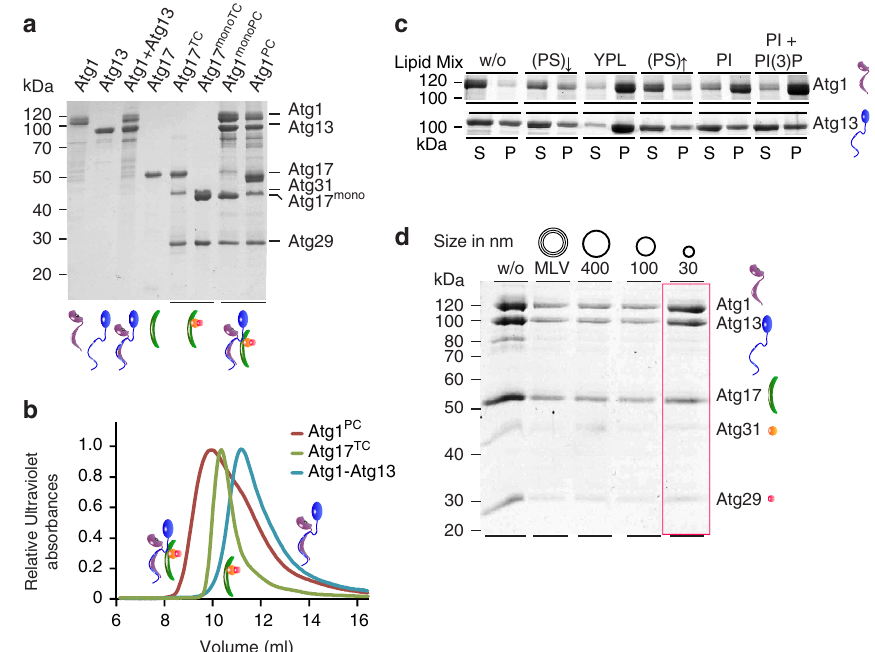
Figure 1 | Reconstitution of Atg1 PC from purified components. ( a ) SDS–PAGE of recombinantly expressed and SEC-purified Atg1–kinase complex subunits. Atg17 TC and Atg17 monoTC were co-expressed; Atg1–Atg13, Atg1 PC and Atg1 monoPC were reconstituted from single components. ( b ) SEC elution profiles of Atg1 PC (red) compared with that of Atg17 TC (green) and Atg1–Atg13 subcomplexes (blue). ( c ) Liposome sedimentation assays of Atg1 and Atg13. Lipid specificity of Atg1 and Atg13 was assessed by comparing their interaction with SUV containing 10mol% PS ([PS] k ), YPL-extracts, 40mol% PS ([PS] m ), 30mol% PI, or 25mol% PI supplemented with 2.5mol% PI(3)P. S, supernatant; P, pellet. ( d ) Floatation assay of YPL-large unilamellar vesicles (LUVs) and MLVs of different sizes with Atg1 PC . Atg1 PC is efficiently recruited to membranes with high curvature (red box). Cartoons represent subunits and